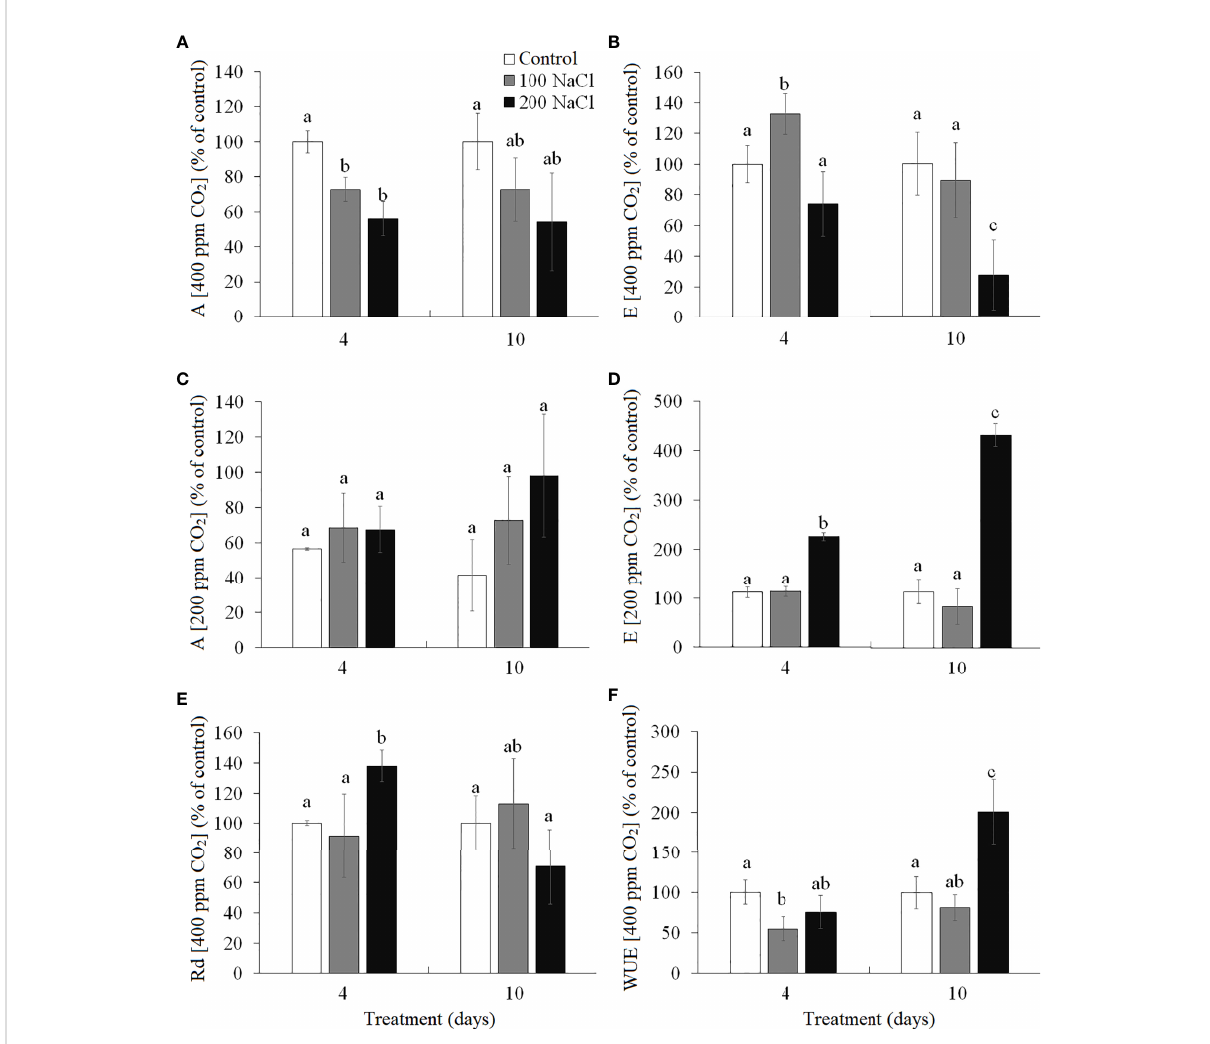
FIGURE 2 Effect of 4- and 10-day treatments with low (100 mM NaCl) and moderate (200 mM NaCl) salinity on CO 2 /H 2 O-gas exchange in Kochia prostrata shoots. (A) Apparent photosynthesis measured at 400 ppm CO 2 . (B) Transpiration intensity measured at 400 ppm CO 2 . (C) Apparent photosynthesis measured at 200 ppm CO 2 (is expressed in percent of control at 400 ppm CO 2 ). (D) Transpiration intensity measured at 200 ppm CO 2 (is expressed in percent of control at 400 ppm CO 2 ). (E) Dark respiration measured at 400 ppm CO 2 . (F) Water use ef fi ciency (WUE) was calculated as the ratio of apparent photosynthesis to the transpiration rate ( A / E ) at 400 ppm CO 2 . Values are means ± standard errors of one experiment with three biological replicates. The different letters show statistically different means at P ≤ 0.05 (Tukey